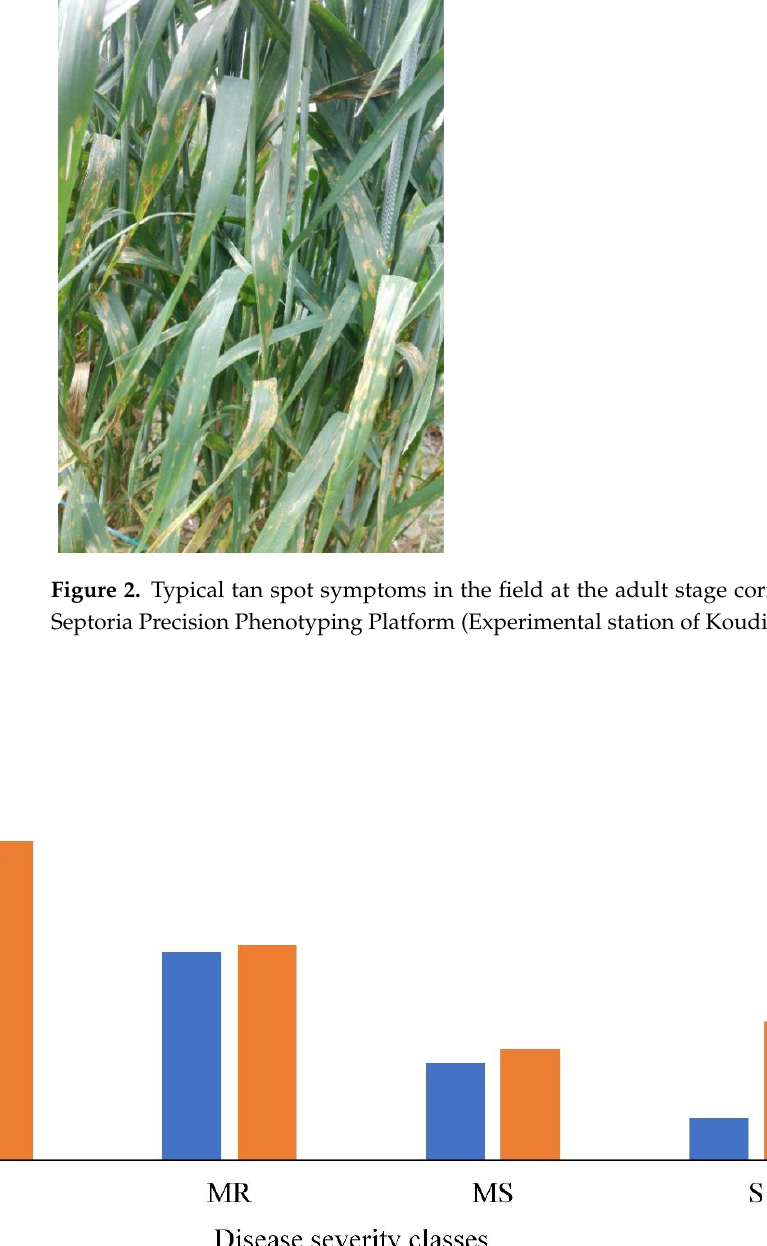
Figure 3. Frequencies of resistance levels (%) of the 113 durum wheat accessions to tan spot disease in the field at seedling and adult stages in the 2018–2019 cropping season.